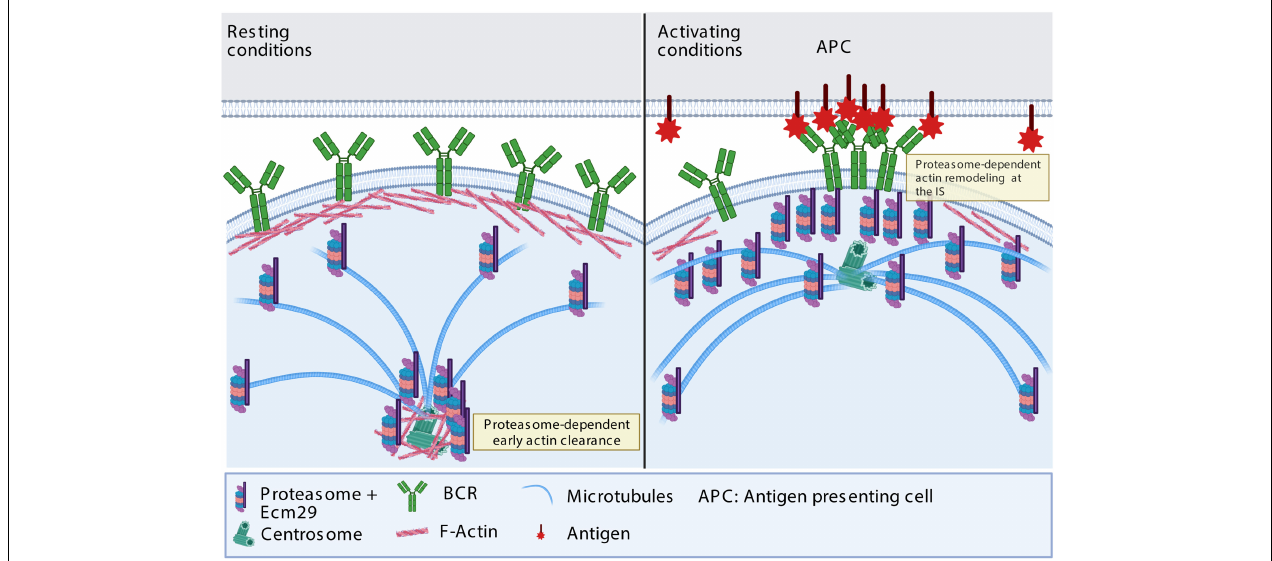
FIGURE 8 | Proposed model: In resting conditions, Ecm29 enhances proteasome localization at the centrosome. Upon activation, Ecm29 regulates the distribution of the proteasome at the synaptic interface. The subcellular localization of the proteasome between the centrosome and the immune synapse regulates actin remodeling in both compartments. At the centrosome, the proteasome facilitates early actin clearance and therefore centrosome translocation at the synapse, whereas at the immune synapse, the proteasome enhances actin remodeling by reducing its stability, thereby promoting cell spreading, BCR clustering and signaling. Further studies are required to determine which actin regulatory proteins are degraded by the proteasome, upon B cell activation and contribute to actin